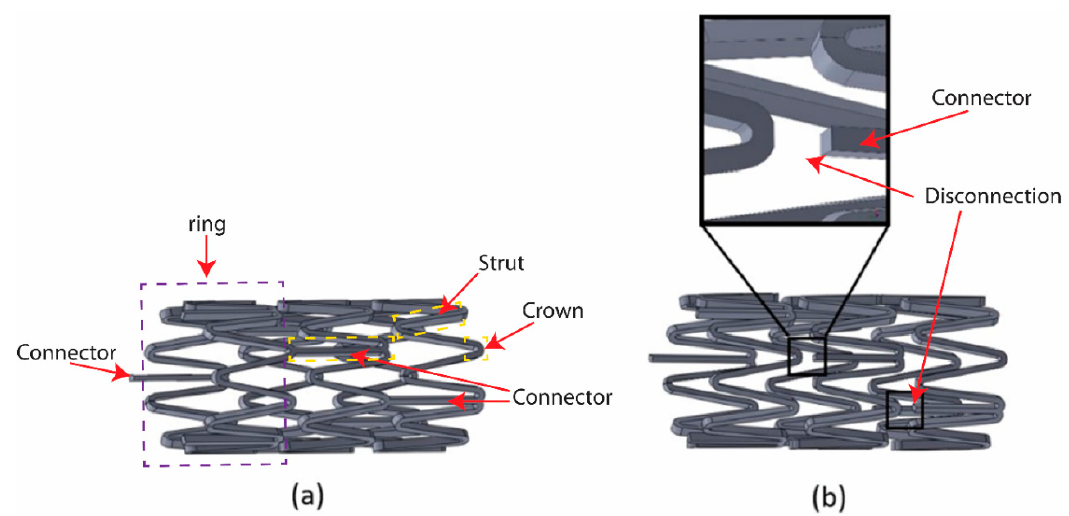
Figure 3. 3D topologies of ( a ) multi-connector and ( b ) single-connector stent antennas.